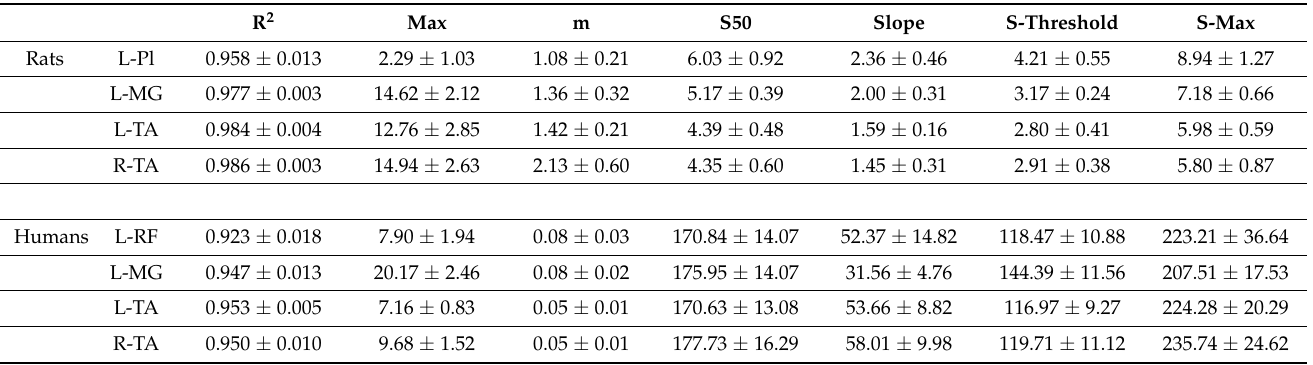
Table 1. Parameters of sigmoid function for the TEP recruitment curves in intact animals and healthy